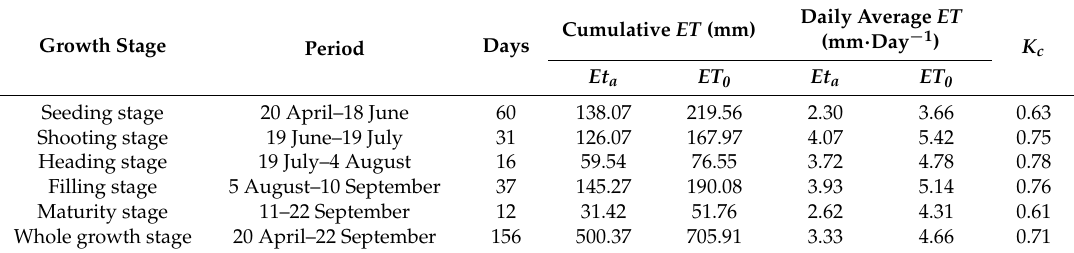
Figure 6. Hourly actual evapotranspiration ( ET a ) and soil moisture content ( smc ) at 10-cm depth at the Yingke site from November 2007 to January 2009. Table 5. The actual evapotranspiration ( ET a ), reference evapotranspiration ( ET 0 ) and crop coefficient ( K c ) during different growth stages at the Yingke site in 2008.